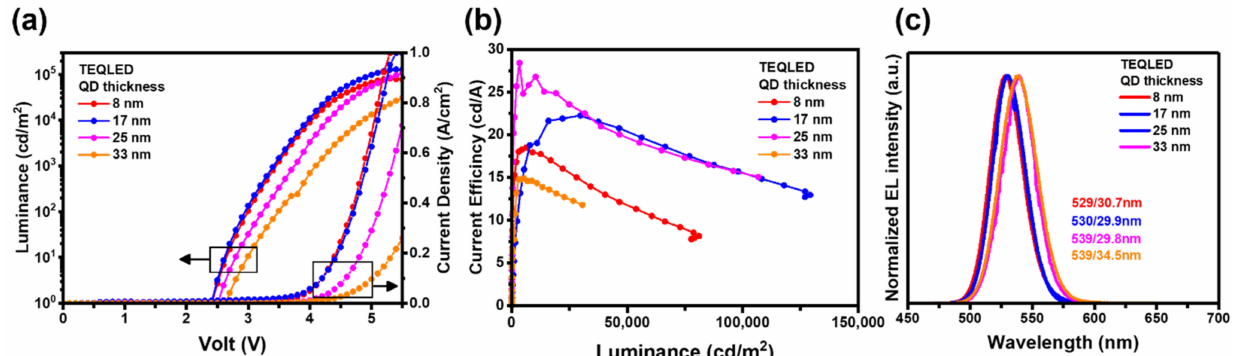
Figure 6. ( a ) J – V – L and ( b ) CE-L characteristics, and ( c ) EL spectra of TEQLED with different QD thickness. The structure of TEQLEDs was IAI anode/PEDOT:PSS (40 nm)/PVK (17 nm)/QDs (x nm)/ZnO (30 nm)/Ag (30 nm)/MoO 3 (30 nm). In order to meet the display criteria in green wavelength, the ZnO thickness was increased to 30 nm to form a resonant wavelength close to ~534